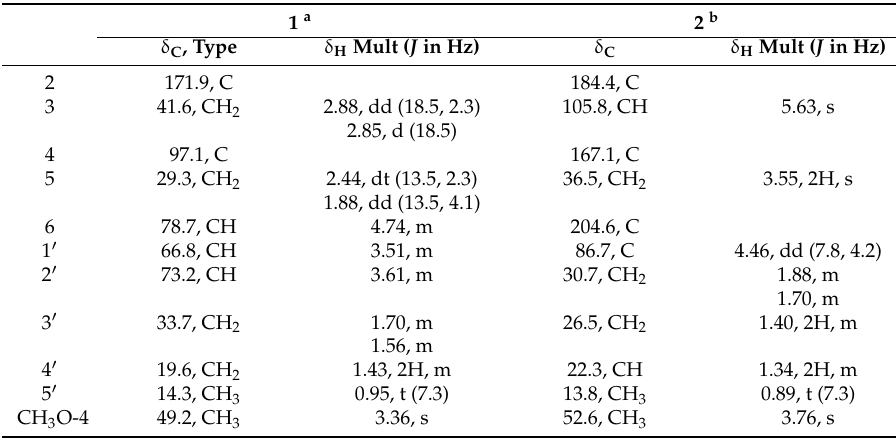
Table 1. NMR data of compounds 1 , 2